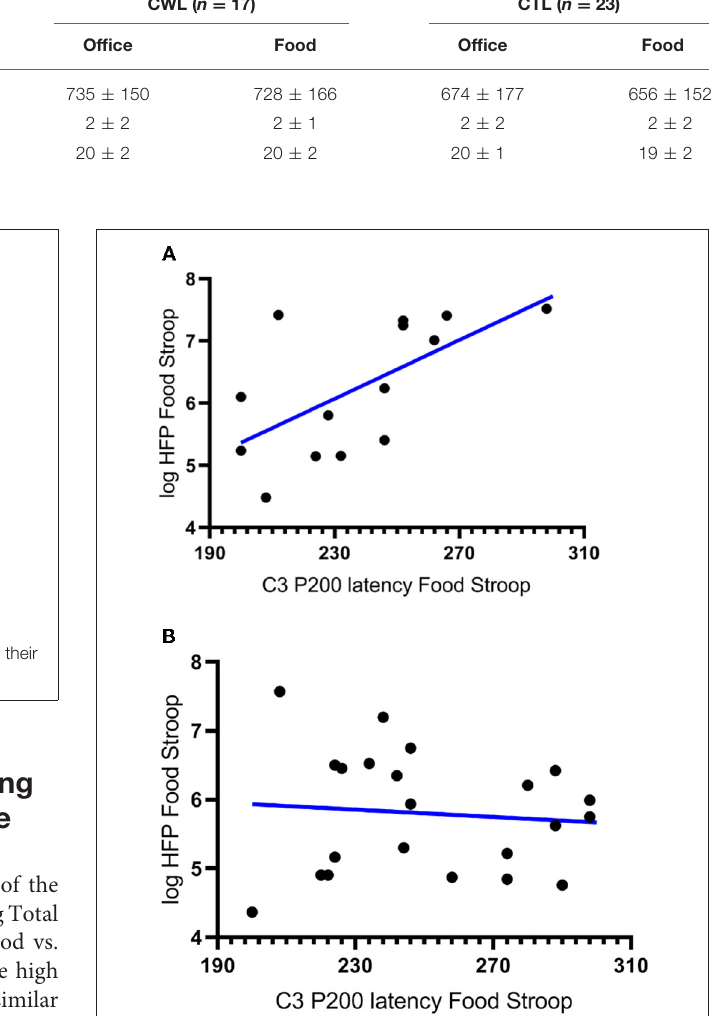
FIGURE 3 | Correlations between the latency of participants’ P200 components evoked by Stroop cues at the left central (C 3 ) electrode and the log High Frequency power (logHFP) in their cardiac spectrograms during the Food Stroop. (A) clinically relevant weight loss (CWL; ≥ 5% of body mass r